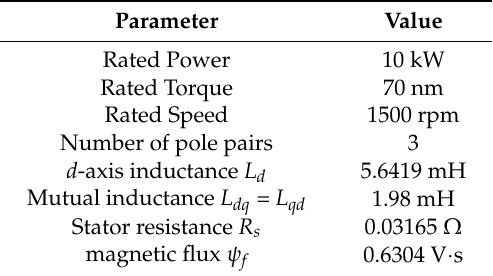
Table 1. Interior IPMSM Specification.